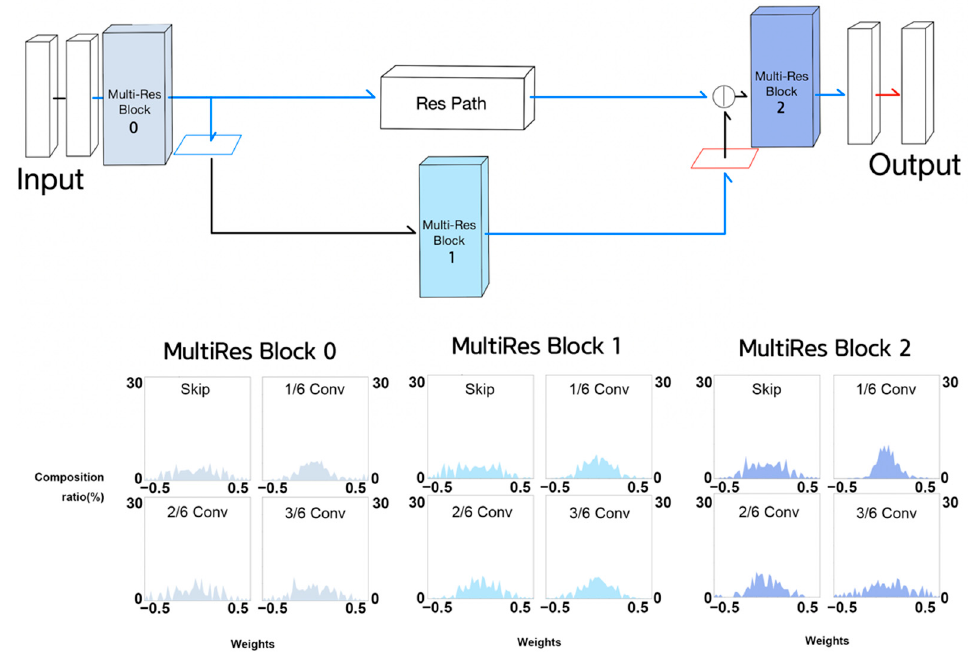
Figure 14. Quarter MultiResUNet of kernel weights histogram.